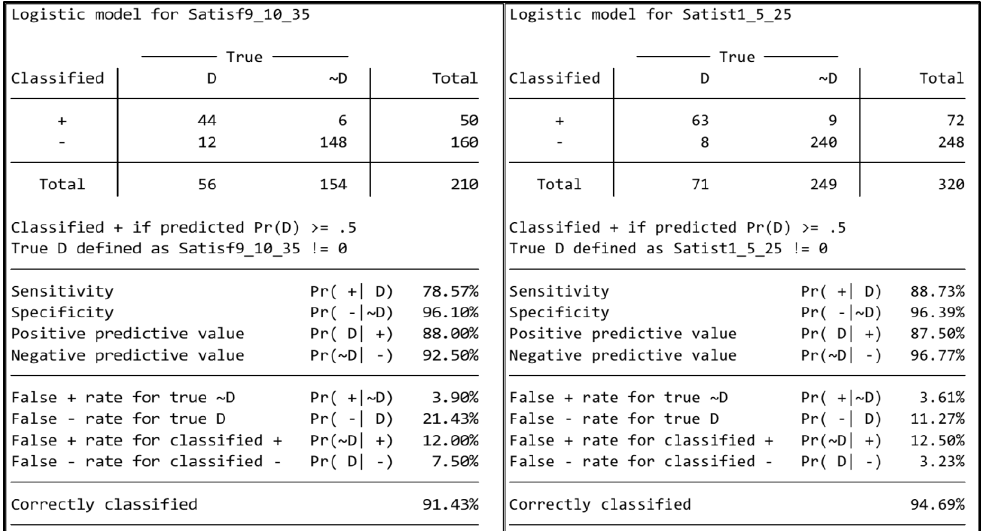
Figure 1. Classification statistics and table logit models (Models 1 y 2).